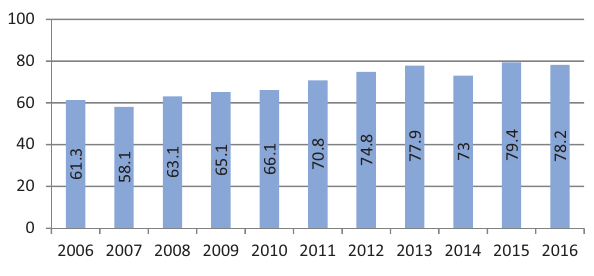
Figure 9. Load factor in international passenger traffic of